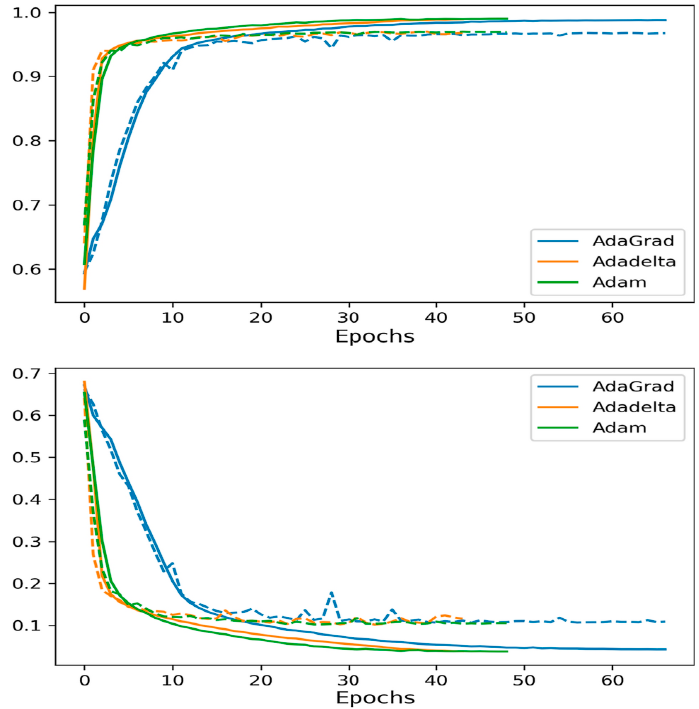
Figure 11. The training and validation (loss and accuracy) of the TL-MVF model for various optimizers. Validation scores--dashed lines; training scores--solid lines.